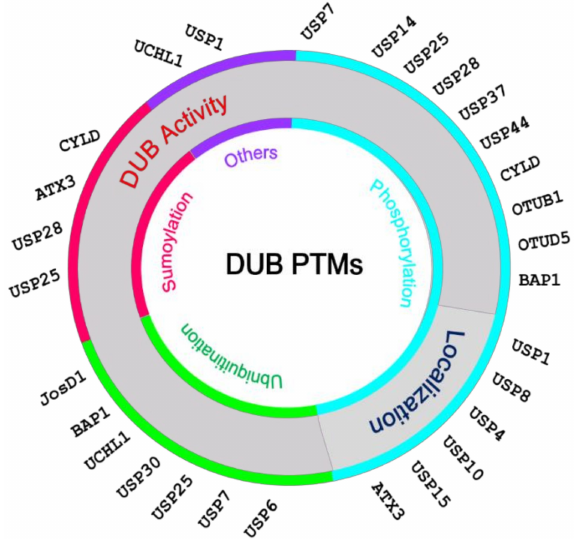
Figure 2. Post-translational modifications (PTMs)-mediated regulations on